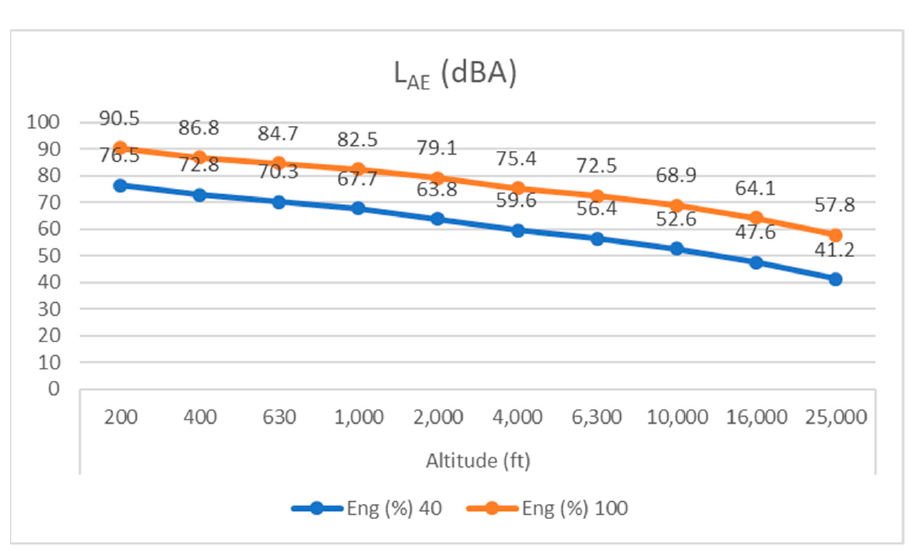
Figure 30. NPD curves, in terms of L AE , for the ATR configuration.